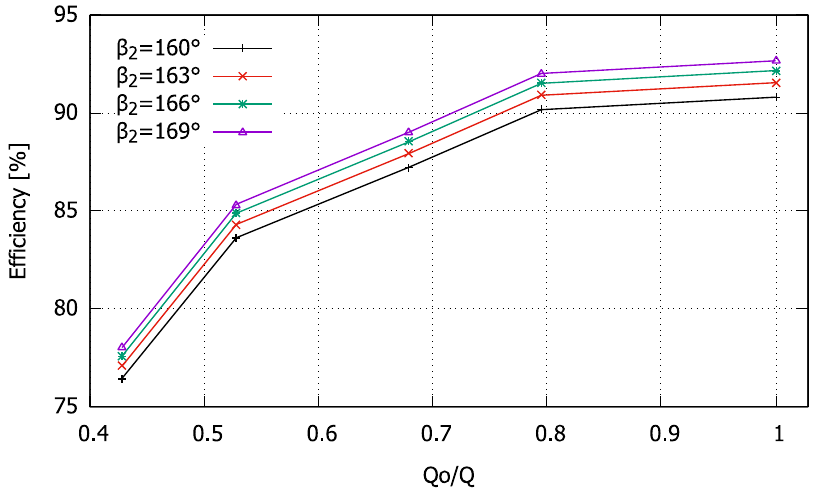
Figure 13. Influence of Beta angle.